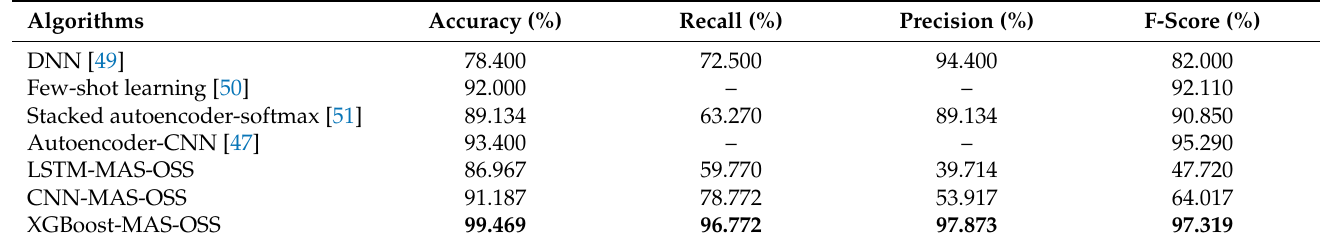
Table 7. Performance comparison with related work on the UNSW-NB15